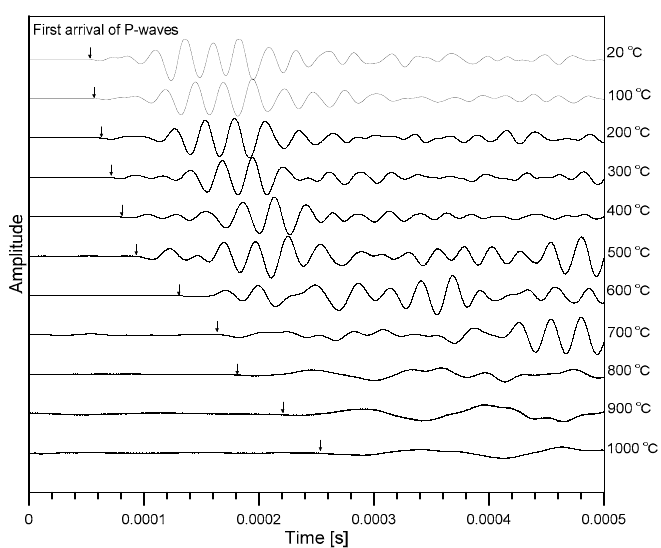
Figure 5. Typical time signals of ultrasonic pulse waves propagating through heat-damaged concrete after exposure to various target temperatures.